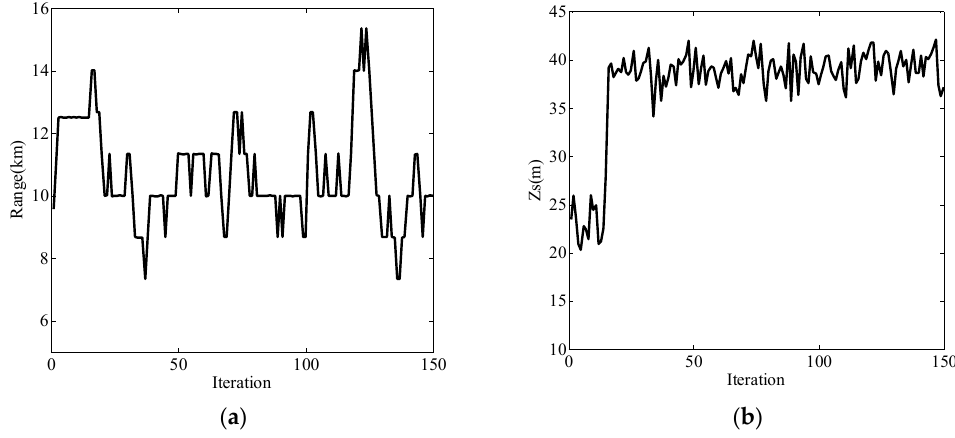
Figure 9. Localization results for pressure as the measured vector. ( a ) Range estimation result with pressure as the measured vector; ( b ) source depth estimation result with pressure as the measured